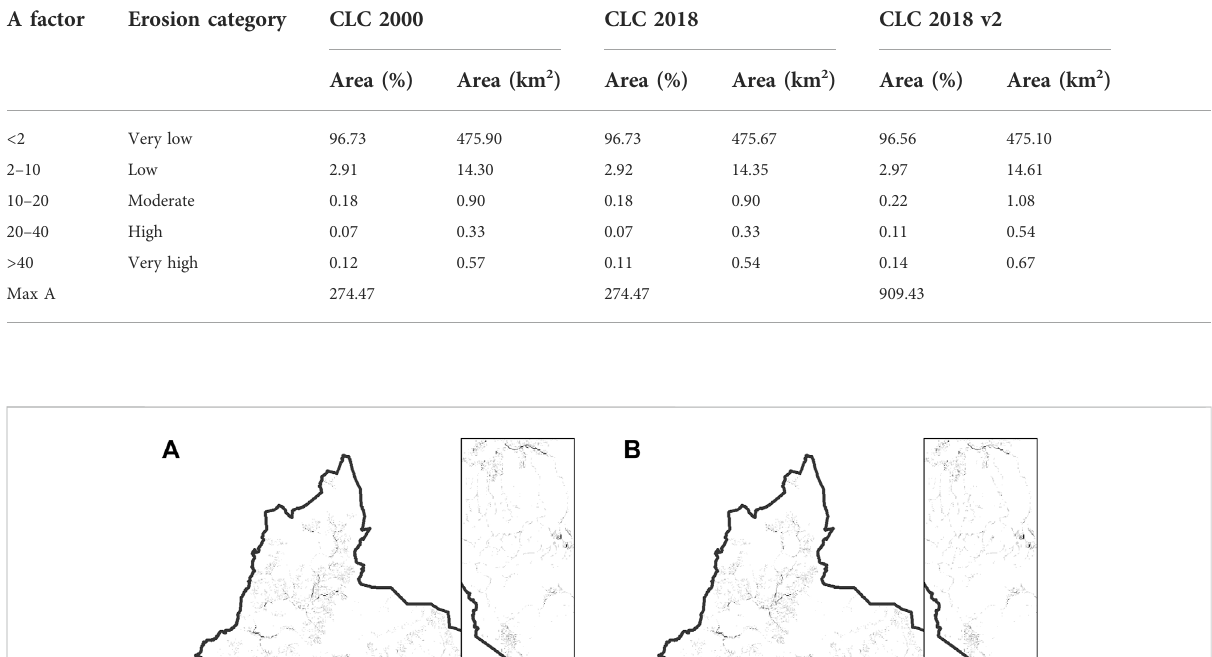
TABLE 3 Categories of soil erosion rate for different categories and different CLC databases for Pale.